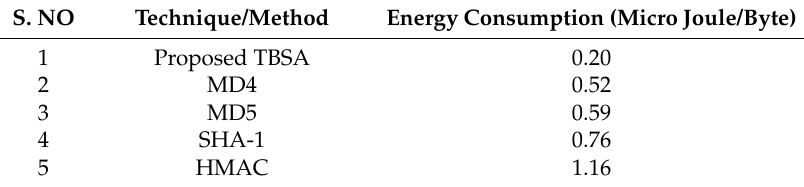
Table 1. Energy Consumption Comparison with Hash Functions.